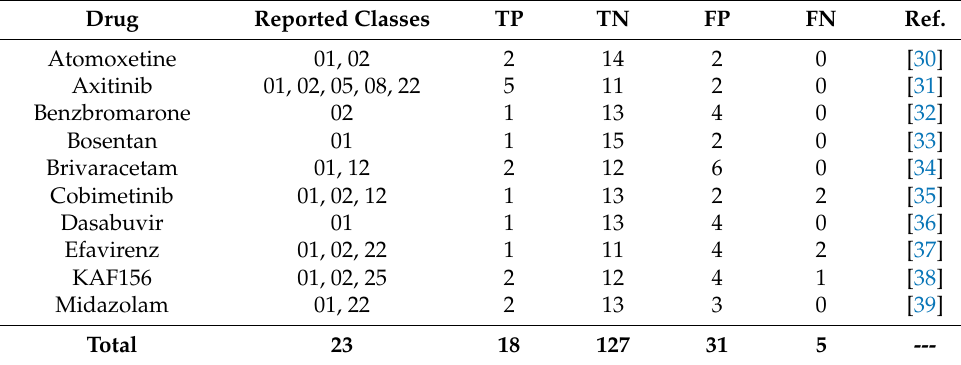
Table 5. Results of the predictive analysis as obtained by applying the MetaClass predictor to an external set of 10